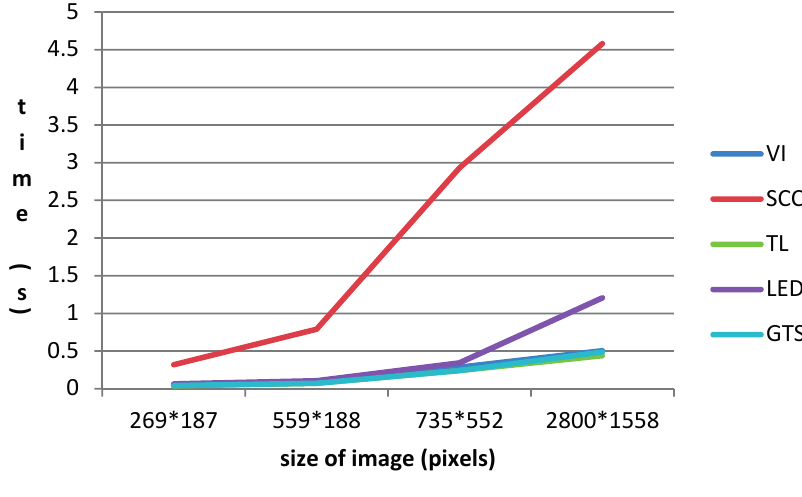
Figure 17. Running time of different